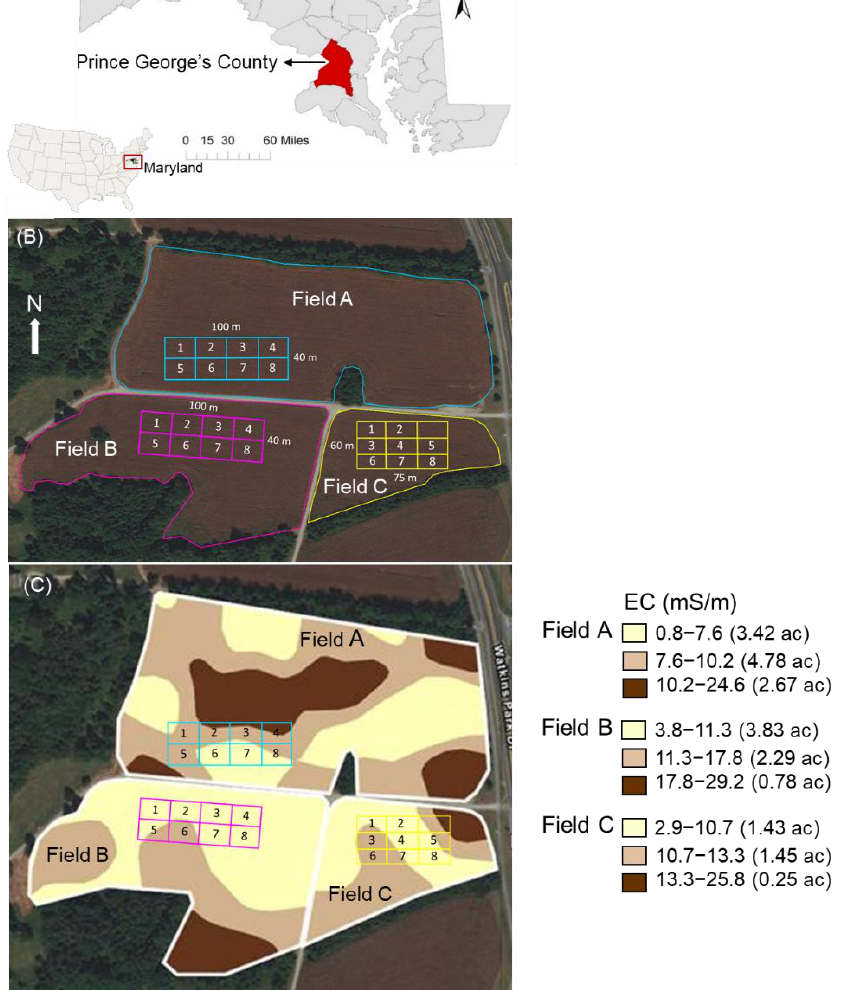
Figure 1. Location maps of ( A ) field sites in Prince George’s County, Maryland, United States, ( B ) sampling sites with marked grids, and ( C ) spatial distribution of soil electrical conductivity (EC) in three fields (ac: acre). Total area of three adjacent fields is 8.34 ha.